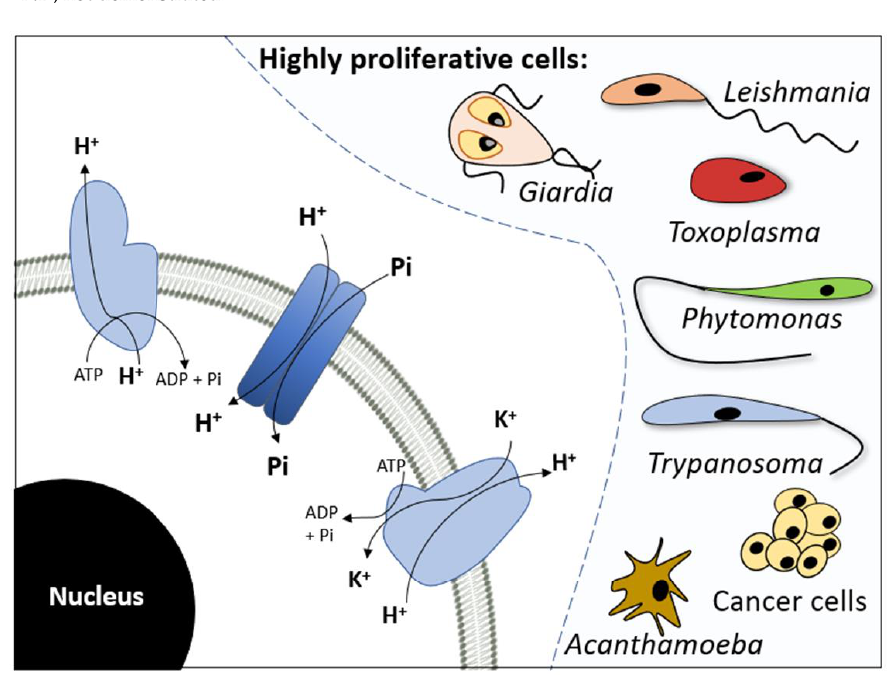
Figure 5. H + -dependent Pi transport mechanisms in highly proliferative cells. V-H + -ATPase and H + , K + -ATPase are coupled to H + -dependent Pi transport in Giardia duodenalis, Leishmania amazonensis , Leishmania donovani, Toxoplasma gondii, Phytomonas serpens, Trypanosoma rangeli , Trypanosoma cruzi , Trypanosoma brucei, cancer cells (breast cancer), and Acanthamoeba castellanii